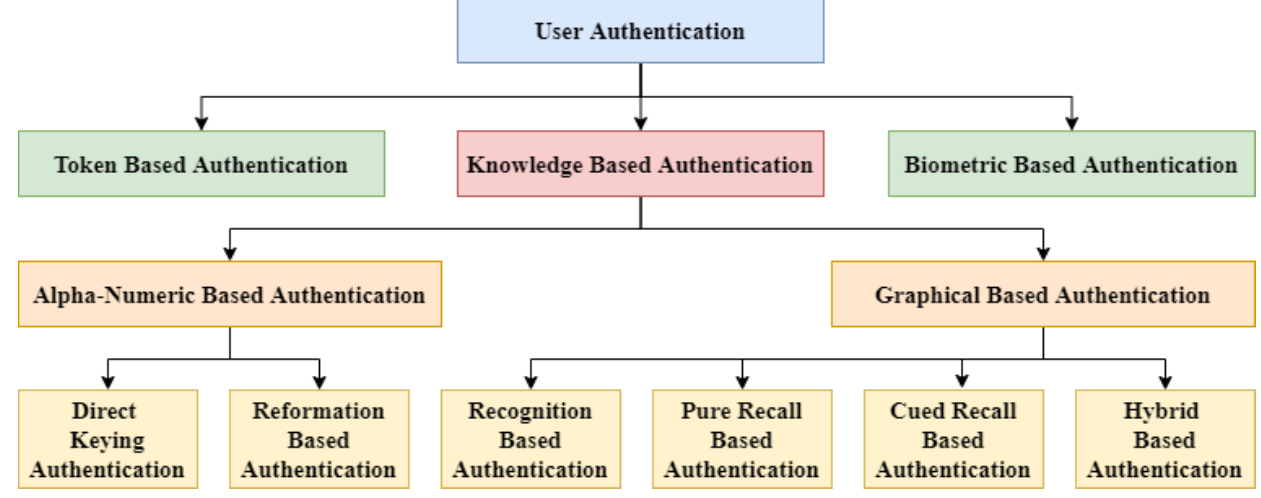
Figure 1. Taxonomy of user authentication